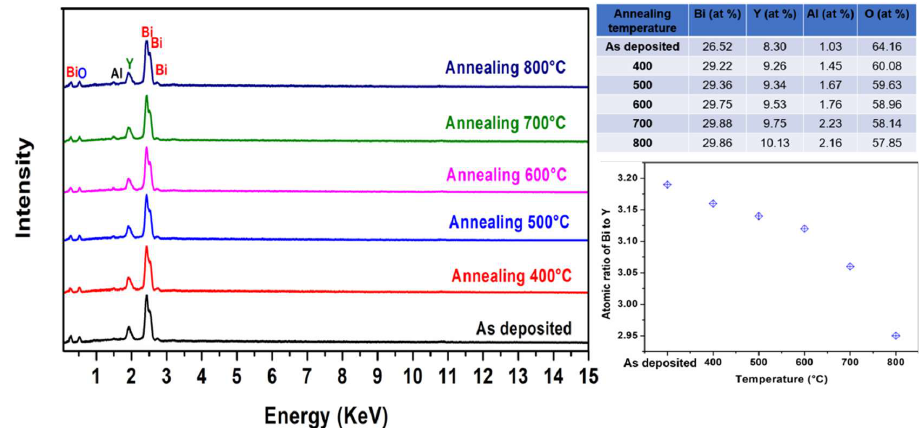
Figure 9. The EDX results of films deposited on alumina plate as function as